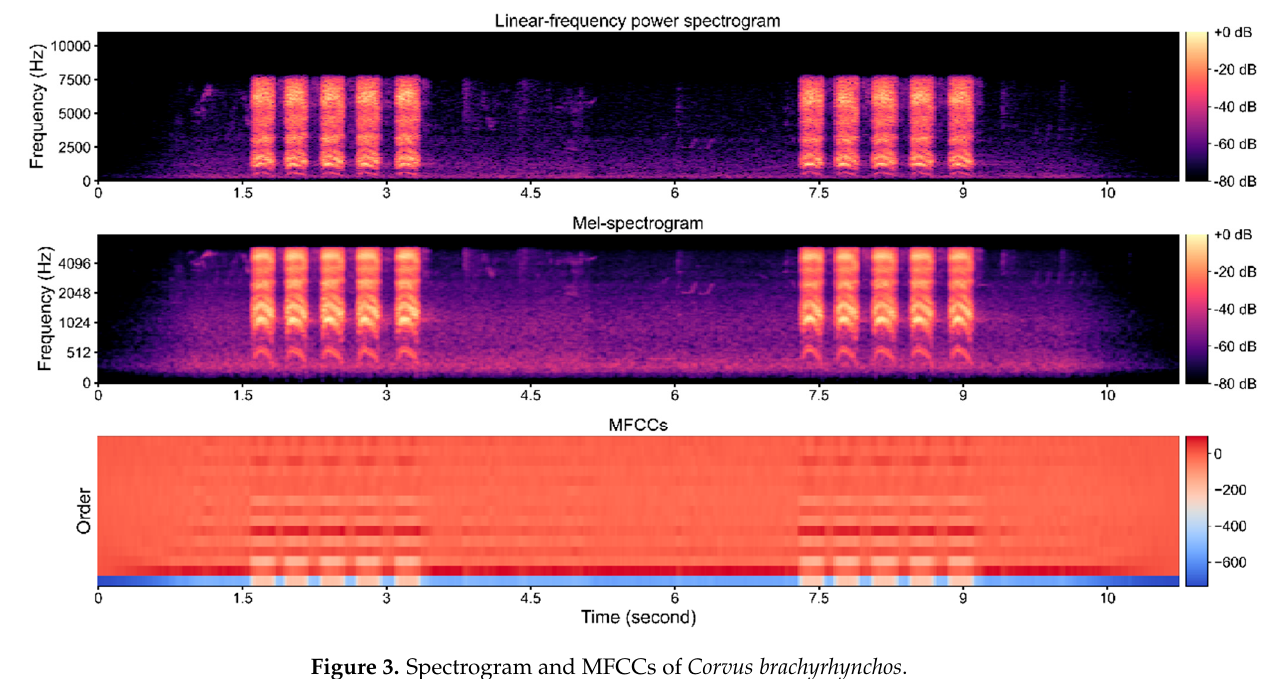
Figure 3. Spectrogram and MFCCs of Corvus brachyrhynchos.